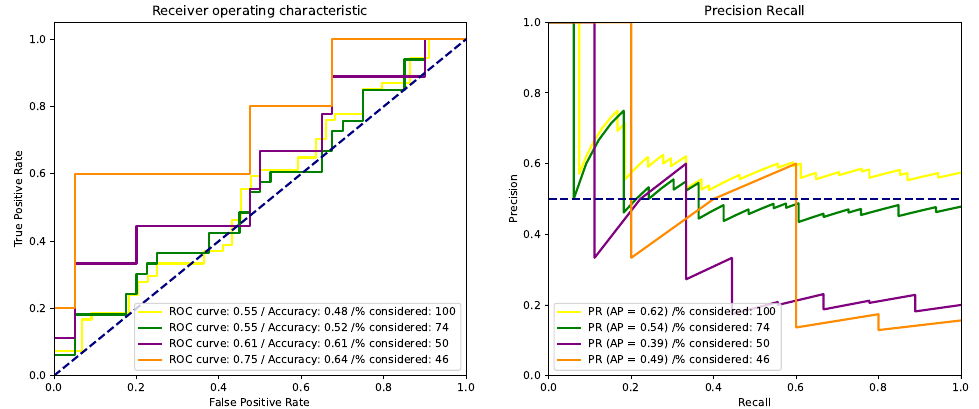
Figure 2. ROC and PR curves for the methylation percentage